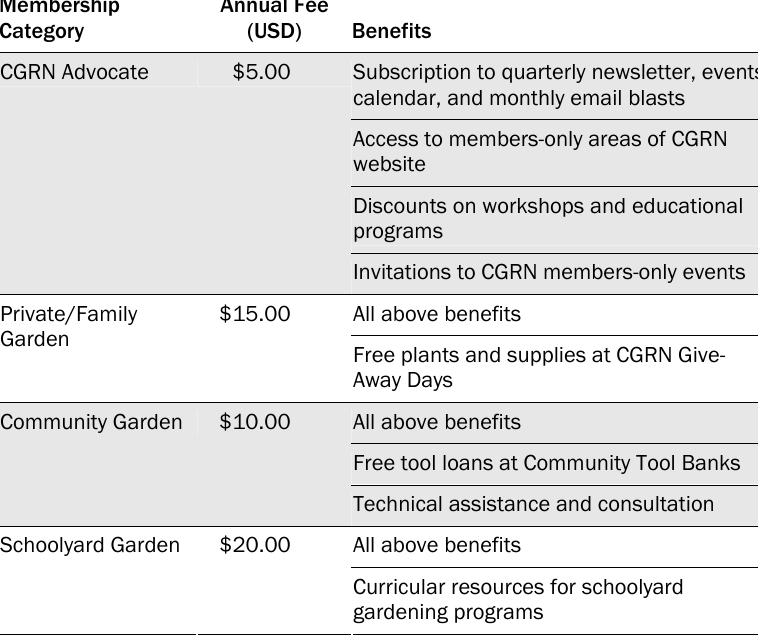
Figure 2. CGRN Membership Categories, Annual Fees, and Benefits